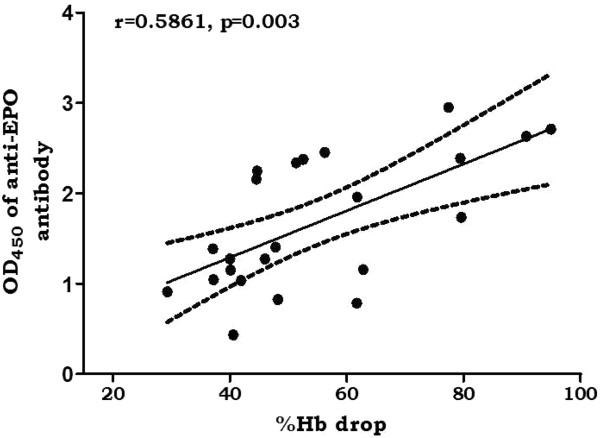
Correlation between %Hb loss and anti-EPO antibody (all mice combined). Total number of samples n = 23 (Balb/c (8), B6 (5), CBA (6), NZW (4)). Dotted lines are 95% confidence intervals and the continuous line is the line of best fit. r is Pearson coefficient. Blood was harvested at minimum Hb in the course of monitoring the haematological and parasitological parameters. These are values of two separate experiments.